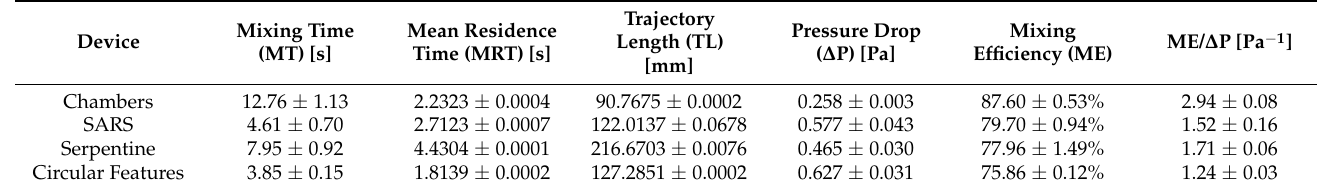
Table 1. Micromixing parameters. Mixing time (MT), mean residence time (MRT), trajectory length (TL) (Characteristic length), pressure drop (ΔP), mixing efficiency (ME), and ratio of mixing index to pressure drop (ME/ΔP) calculated.